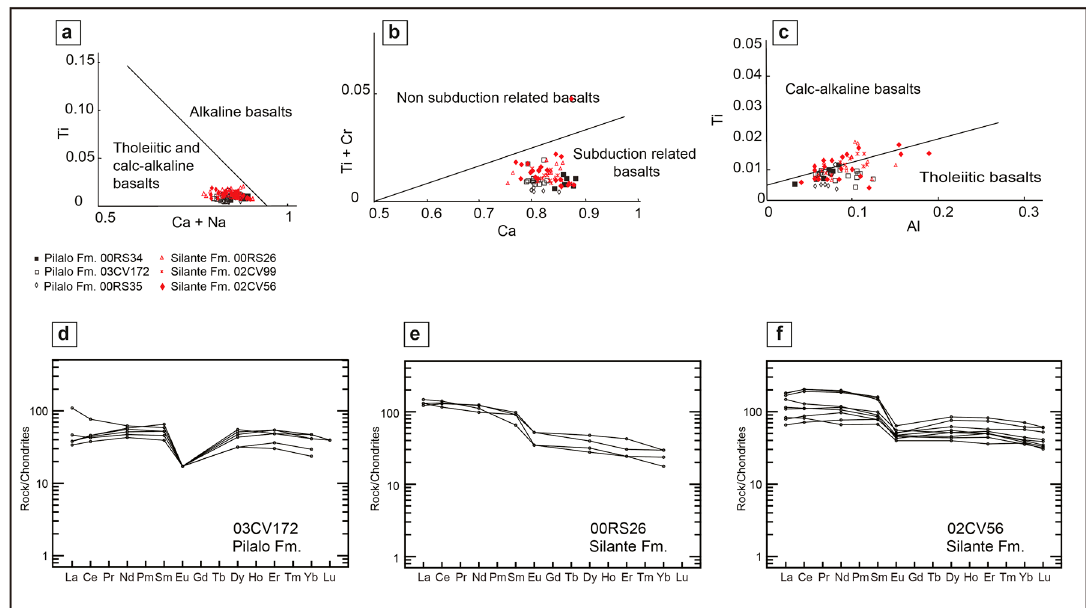
Figure 10. Geochemistry of detrital clinopyroxenes from the Silante and Pilalo formations. ( a ) Ti vs Ca + Na discriminatory diagram from Leterrier et al. [82]. ( b ) Ti + Cr vs Ca discriminatory diagram from Leterrier et al. [82]. ( c ) Ti vs Al discriminatory diagram from Leterrier et al. [82]. ( d ) Chondrite- normalized REE plots of calculated melts in equilibrium with clinopyroxenes of a lava intercalated within the Pilalo Formation (sample 03CV172). ( e ) Chondrite-normalized REE plots of calculated melts in equilibrium with clinopyroxenes of the Silante Formation (sample 00RS26). ( f ) Chondrite- normalized REE plots of calculated melts in equilibrium with clinopyroxenes of the Silante Formation (sample 02CV56). Chondrite normalizing values after Sun and McDonough [87].